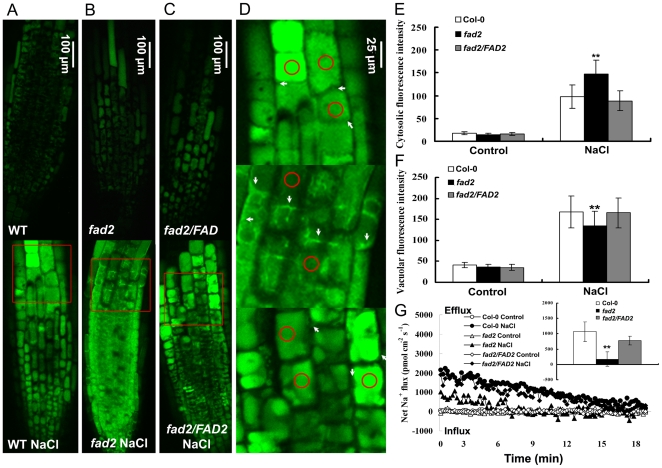
Intracellular Na+ distribution and Na+ extrusion in roots of Col-0, fad2 and fad2/FAD2.(A)-(C) Representative examples (n = 10–12) of CoroNa-Green staining of the root tip region before and after NaCl treatment. (D) Magnifications of marked regions (red boxes) in (A) to (C). Red circles and white arrows indicate the vacuolar and cytoplamic regions, respectively. (E) and (F) Fluorescent intensities in the vacuole and cytosol were calculated for comparison. Error bars indicate SD of at least 100 cells randomly measured from 10 individual seedlings. (G) Net Na+ efflux in root tips. Inserted section show the mean flux rates within the measuring period of 18–20 min in NaCl-treated seedlings. ** indicates significant difference in comparison to wild-type at p<0.01 (Student's t-test). Roots of five-day-old seedlings were stained with CoroNa-Green AM after 72 h of 100 mM NaCl treatment and observed with a confocal microscope.